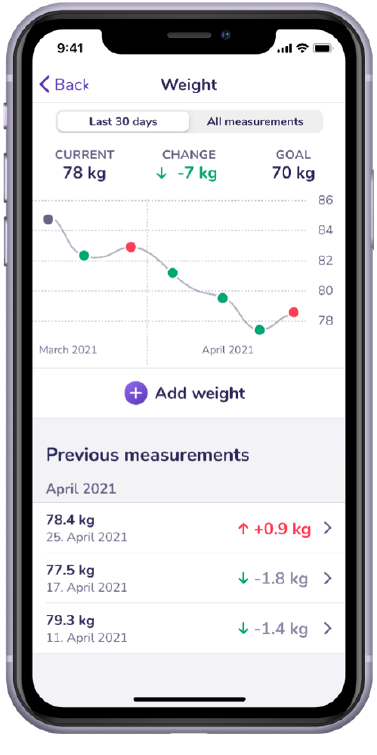
Figure A3. Tracking of weight change.